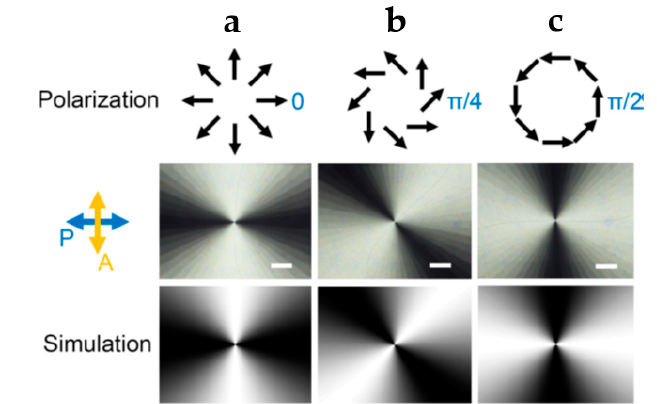
Figure 2. Schematic polarization distributions (top), experimental (middle), and simulated (bottom) intensity distributions of vector beams (VBs) with P = 1, ( a ) ϕ 0 = 0 (radial), ( b ) ϕ 0 = π /4 (vortex), and ( c ) ϕ 0 = π /2 (azimuthal). Cylindrically symmetric polarization distribution provided such fan-like images. Scale bars indicate 200 µ m [25].